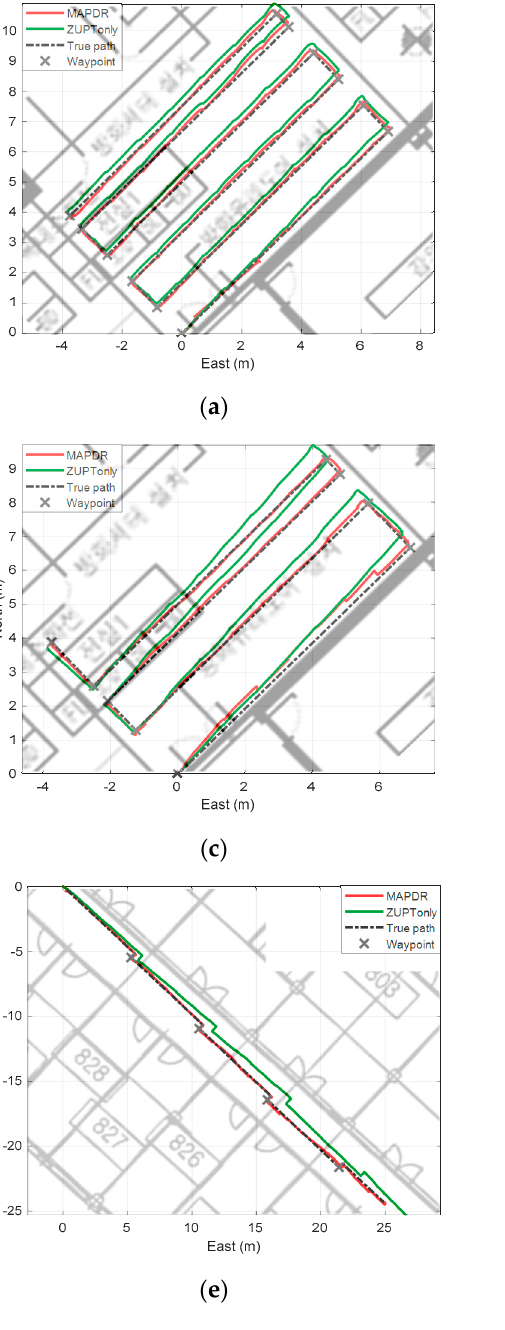
Table 5. Comparison of waypoint position errors.